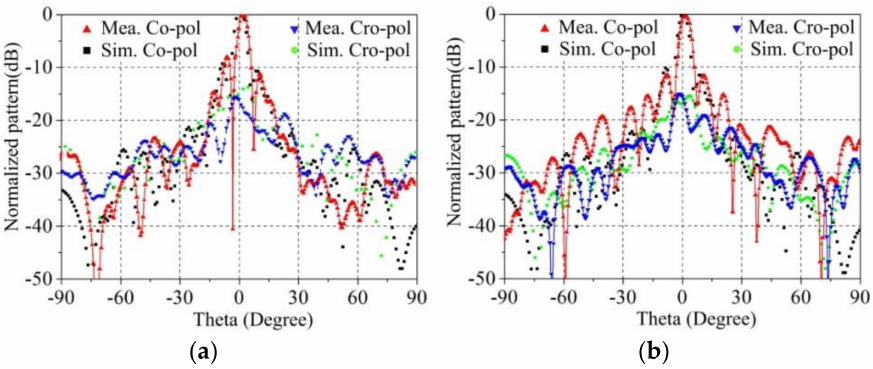
Figure 14. Simulated and measured radiation patterns (dB) of ( a ) E plane and ( b ) H plane at 10